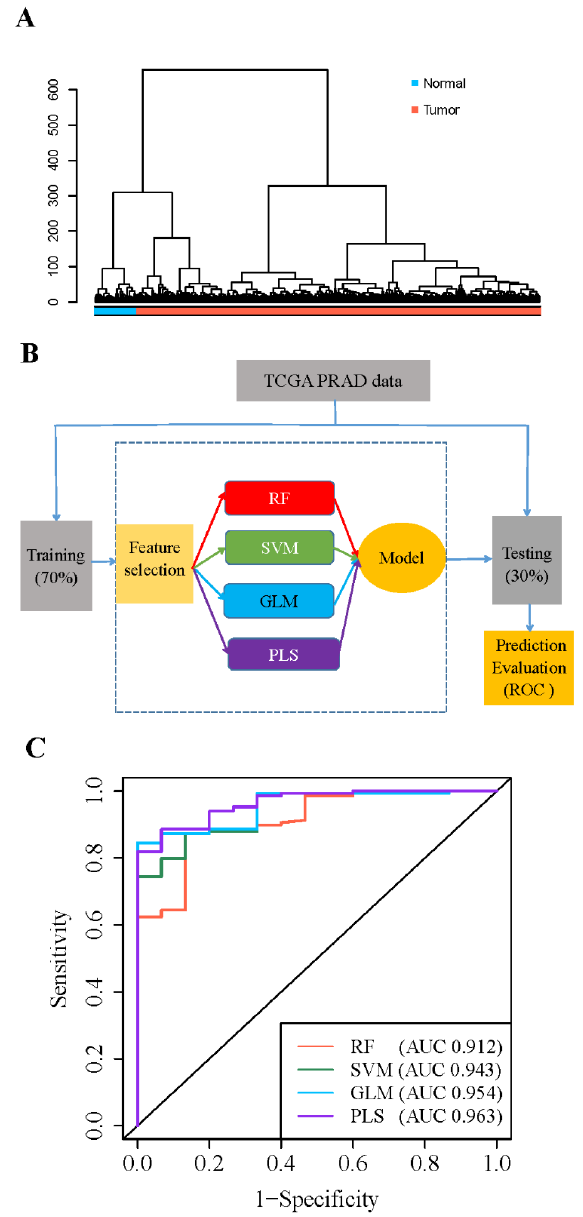
Figure 2. Expression of 5ʹ-tRFs is a diagnostic biomarker for PRAD. ( A ) Hierarchical cluster analyses of PRAD specimens using 5ʹ-tRFs expression profiles. ( B ) A schematic diagram for building machine learning models predictive of PRAD tumors versus normal tissues. RF: random forest; SVM: support vector machine; GLM: generalized linear model; PLS: partial least square. ( C ) ROC curves to evaluate the sensitivity and specificity of 5 (cid:48) -tRF classifiers to discriminate PRAD tumor and normal samples. AUC: the area under the ROC curve. When AUC = 1, the tRF classifier can perfectly distinguish between PRAD tumors and normal